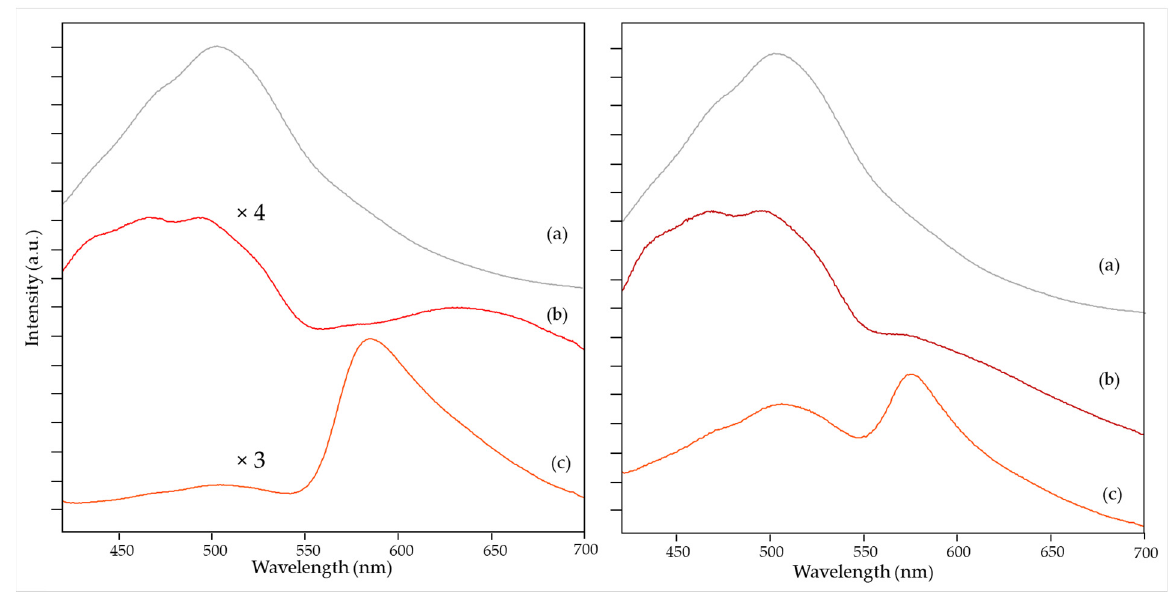
Figure 4. Emission spectra ( λ exc = 365 nm) of: ( a ) a pictorial layer of lead white (grey lines) compared with those of the two fluorescent colorants ( b ) madder lake (red lines) and ( c ) red lead (orange lines), spread with egg yolk or whole egg (15- or 3-years old respectively). ( Left ) before and ( right ) after the self-absorption correction.